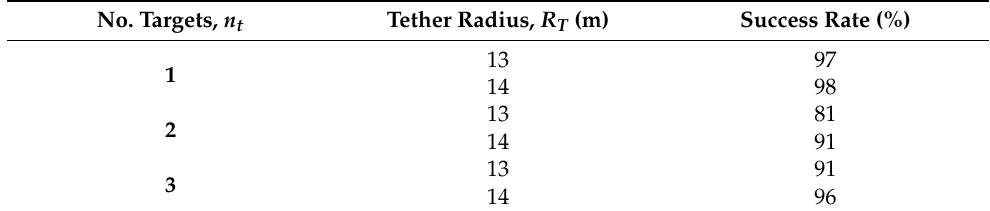
Table 3. Simulation parameter definitions and values. Note the outlier for the case of n t = 2, R T = 13 m where success rate was markedly lower than other